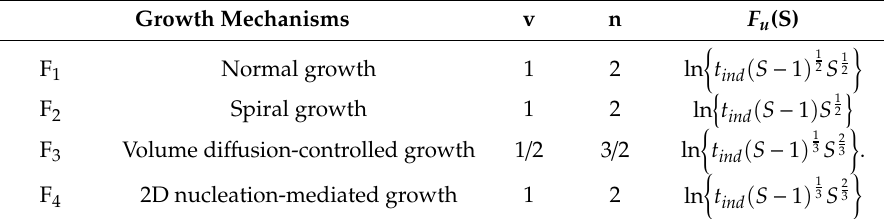
Table 3. The expressions F u (S) for di ff erent growth mechanisms of Li 2 CO 3 .